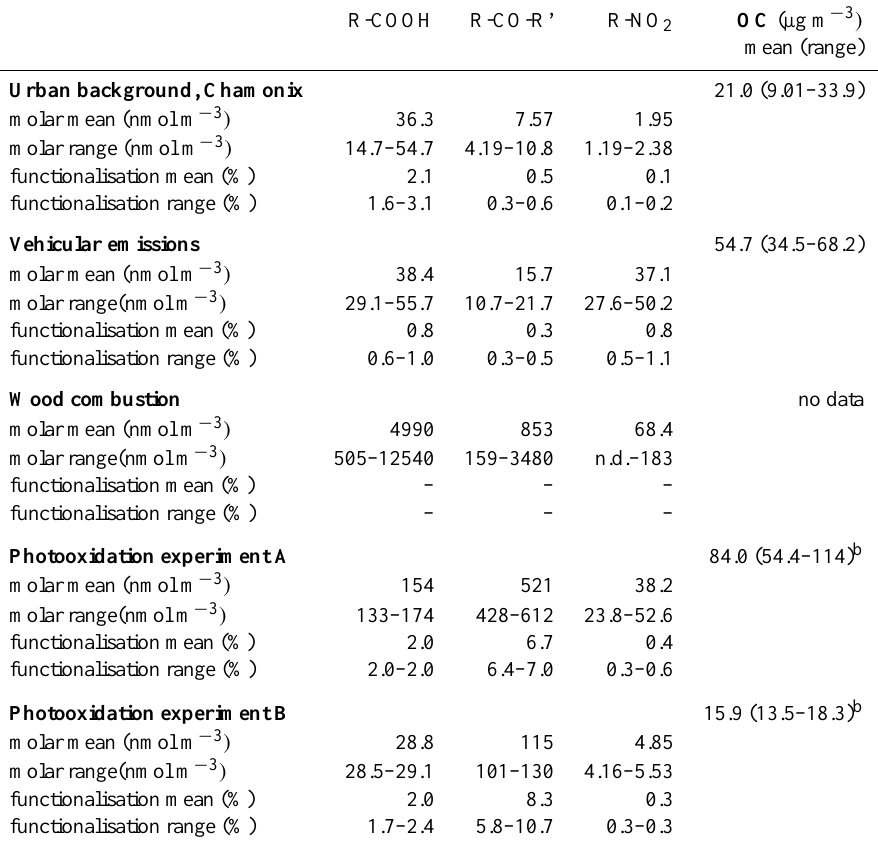
Table 2. Carboxylic, carbonyl and nitro functional groups molar concentrations (nmol m − 3 ) , corresponding functionalisation rates (%) and OC (µgm − 3 ) measured in the different types of atmospheric aerosols: urban background, road traffic and wood combustion emission sources, and SOA formation from o -xylene